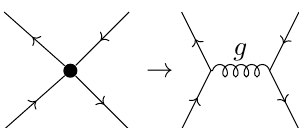
Figure 5. Replacement used to determine the number of closed colour loops in QCD diagrams with four-quark operators. Diagrams with a given number of four-quark vertices contain the same number of colour loops as diagrams where each four-quark vertex is replaced by the subdiagram with gluon exchange that is depicted on the right-hand